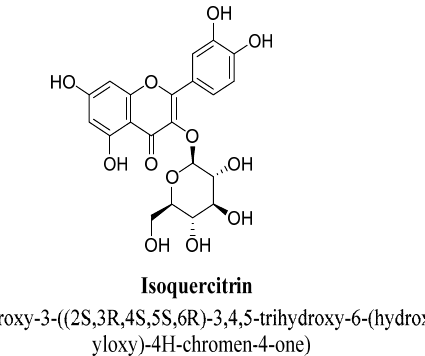
Figure 18. Isoquercitrin.